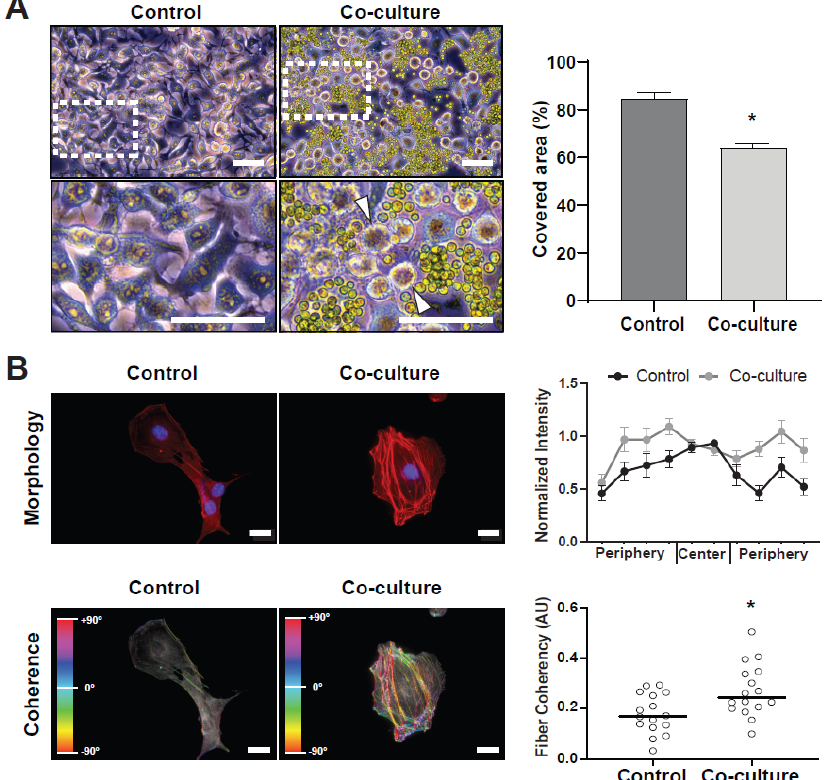
Figure 3. Co-cultures of C. reinhardtii and C32 tumor cells. Microalgae were added to sub-confluent C32 seeded plates and left for 24 h in standard culture conditions. A general view of the co-culture is shown in ( A , left ), with arrowheads showing cells that are detaching from the plate. A significantly lower surface area was found to be covered by C32 cells in co-culture conditions ( A , right ). A cytoskeleton analysis of the cells shows that actin fibers increased in the periphery of the cells when co-cultured ( B , upper right ). The actin fiber directionality analysis is color coded, and results show significantly increased fiber coherency in co-culture conditions ( B , lower right ). All assays were performed in at least three independent experiments and data are presented as average + SE. Scale bars represent 50 µ m in ( A ) and 20 µ m in ( B ). p ≤ 0.05 was considered as significant using a Mann–Whitney test. * = p ≤